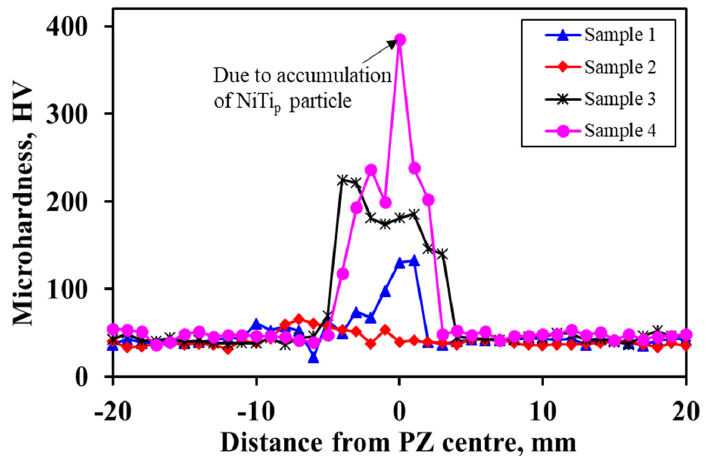
Figure 11. Microhardness profile measured across the cross-section of the fabricated